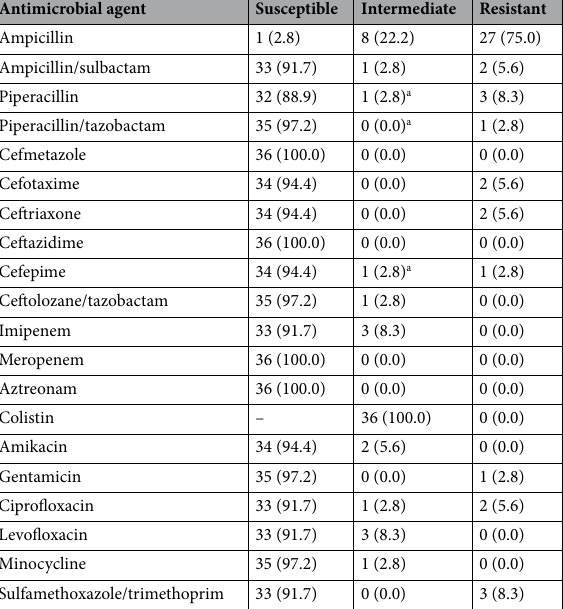
Table 2. Antimicrobial susceptibility of 36 rmpA -positive K. pneumoniae isolates from patients with bloodstream infections. Data are expressed as number (%). a Data are expressed as susceptible-dose dependent (SDD).